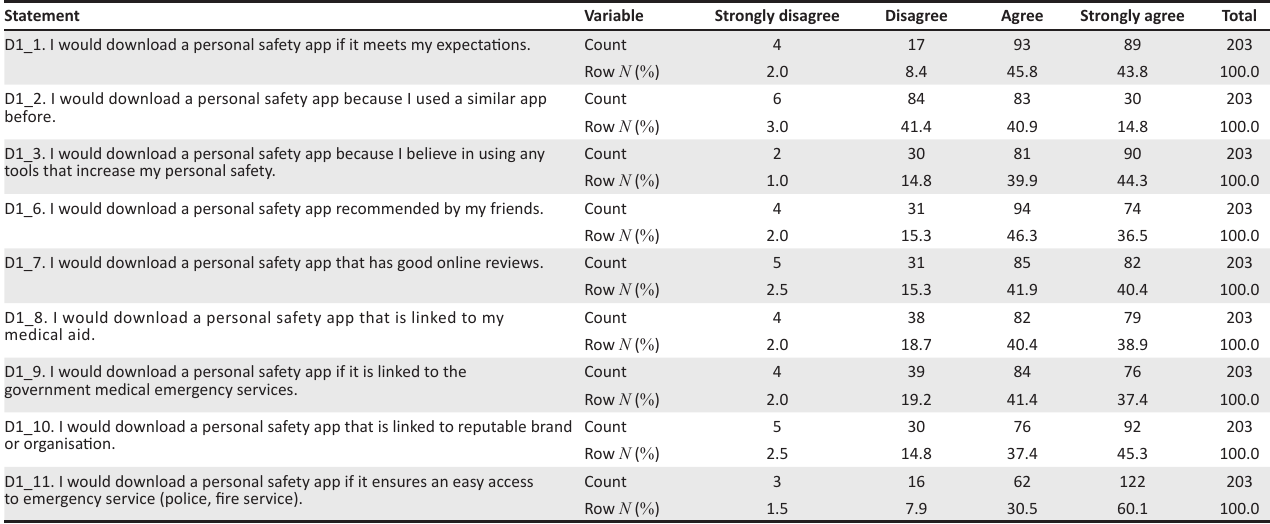
TABLE 1: Responses on intentions to download personal safety apps ( n = 203).